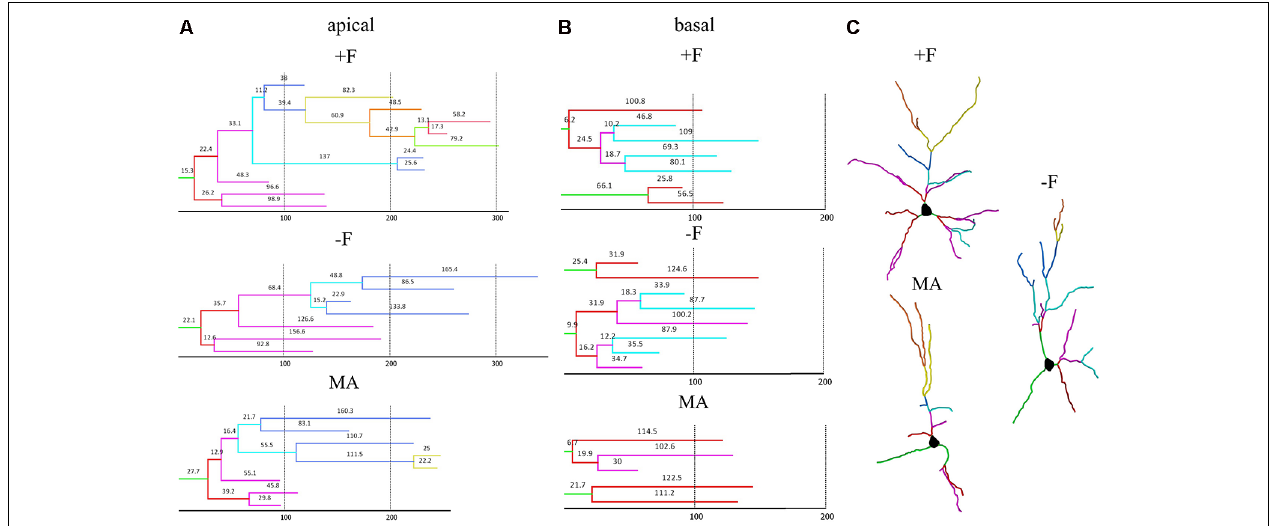
FIGURE 5 | Dendrograms and reconstructions of representative neurons in the different rearing groups to visualize the differences in dendritic length and complexity in female offspring. (A,B) Representative dendrograms for apical and basal dendrites; hatched vertical lines and numbers on each segment indicate length in µ m. (C) Reconstructions of representative pyramidal neurons; branch orders are labeled by individual colors. +F = biparental control group, − F, fatherless group reared by mother; MA, reared by mother and